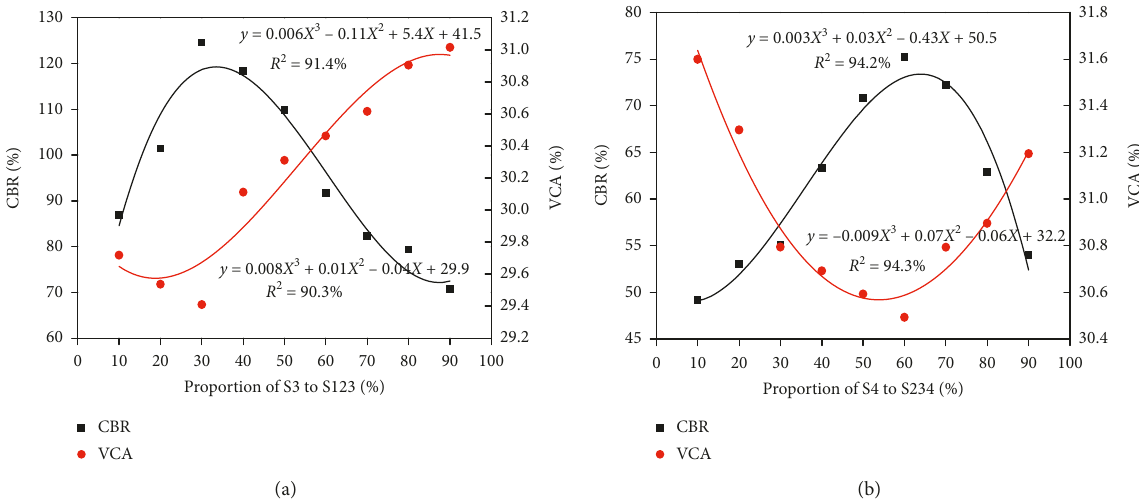
Figure 7: CBR and VCA of two kinds of three-aggregate mixtures with continuous gradation (a) S123 and (b)